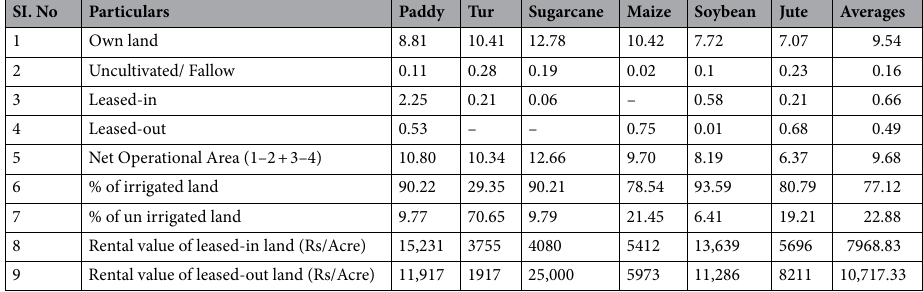
Table 4. Crop-wise, average size of operational landholdings of the sample farmers (Acres). Source: Authors’ estimates using field survey data. Selected study